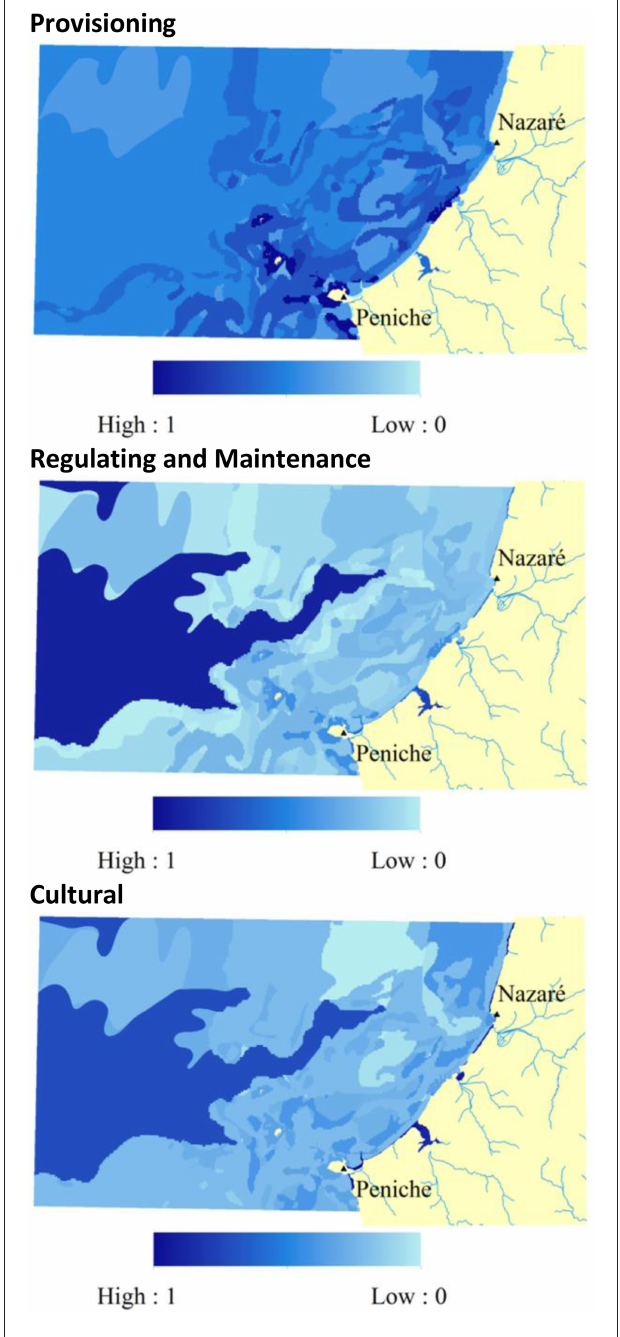
FIGURE 5 | Marine ES availability maps for the complex Atlantic region between Peniche and Nazaré: Provisioning, Regulating and Maintenance, and